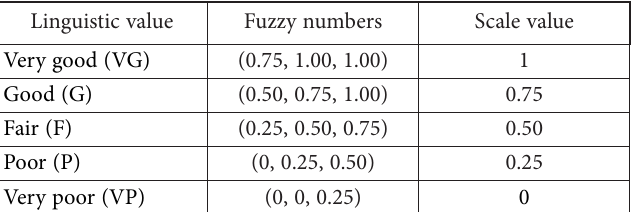
Table 5. Linguistic values and scale values Linguistic